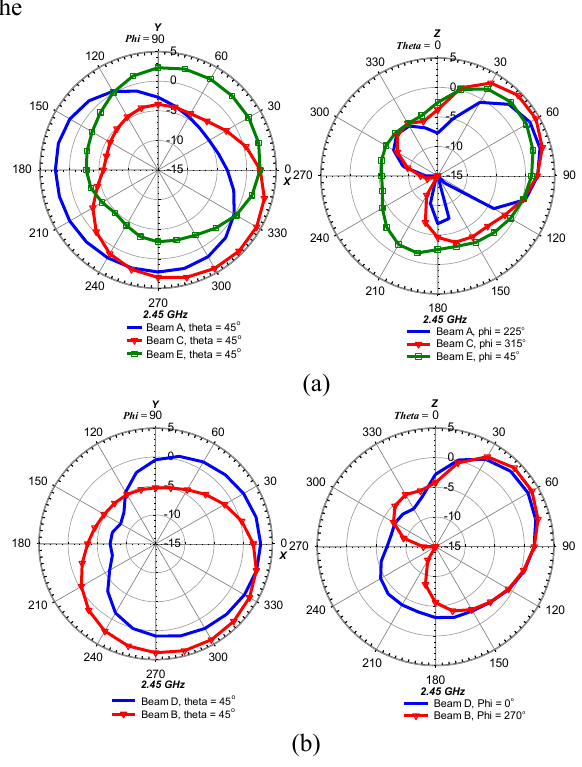
Figure 13: Simulated radiation patterns of various radiation beams for antenna cell 1: (a) beams A, C, and E and (b) beams B and